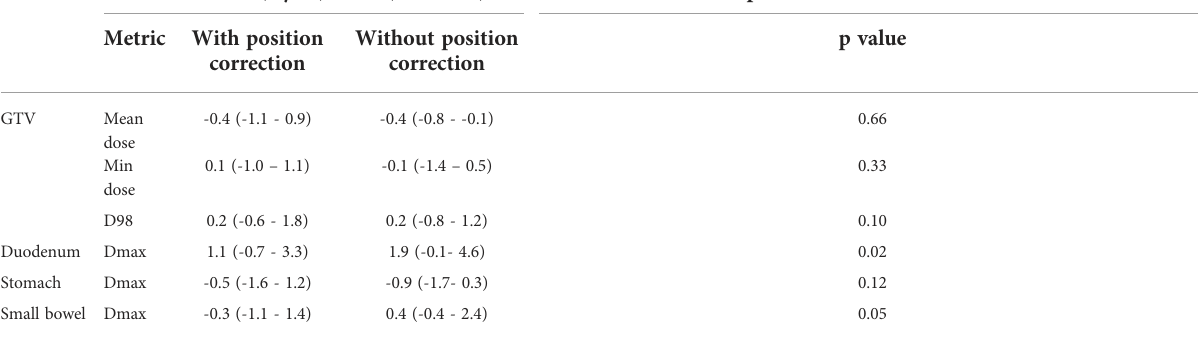
TABLE 2 The mean (range) difference between planned and delivered dose to GTV and gastrointestinal OARs with and without position corrections. Structure Difference between total plan and delivered